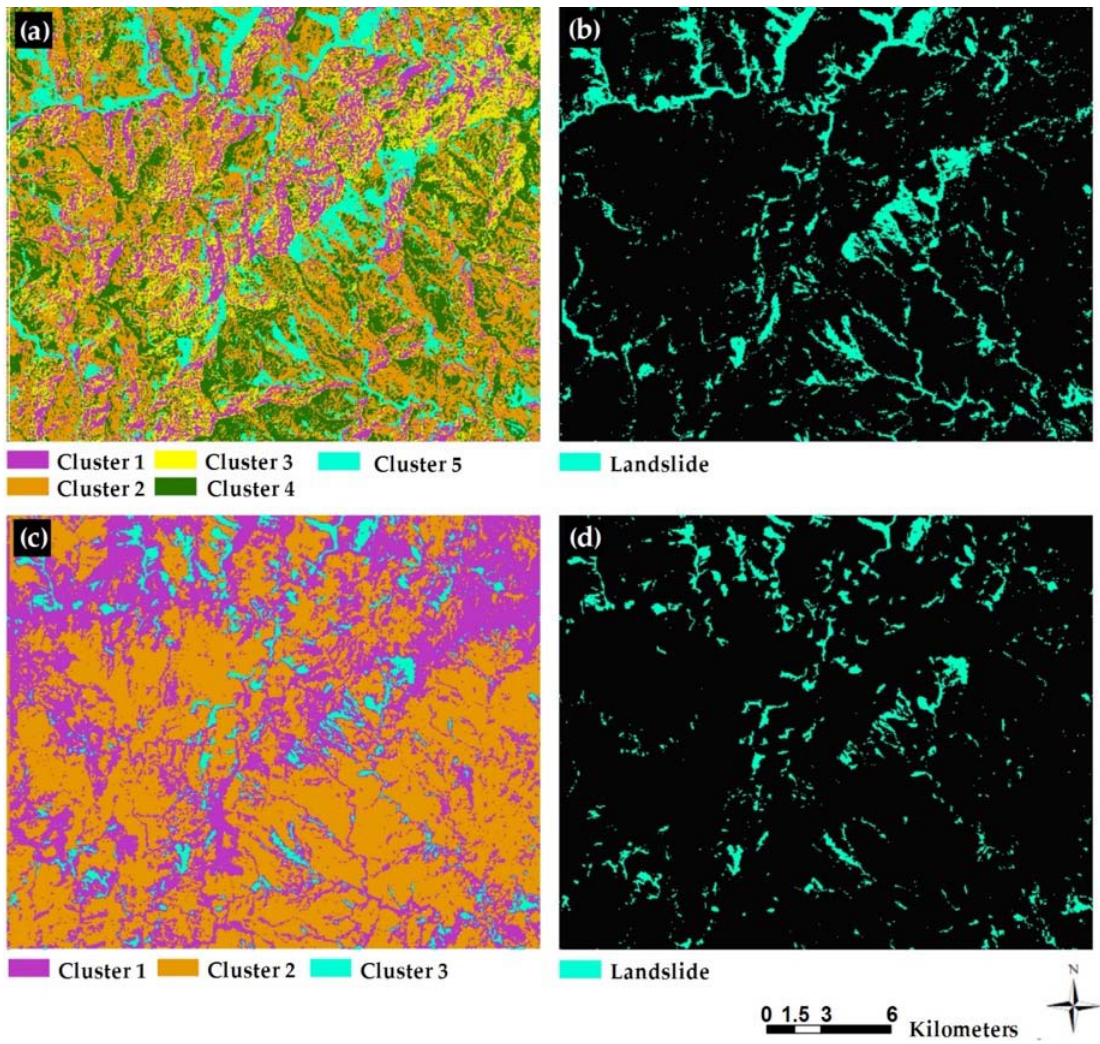
Figure 14. Clustering landslides in Taiwan’s case study. ( a , b ) Clustering and binary landslide map based on MNF features, slope, and NDVI, while ( c , d ) show the same features as well as the deep features.